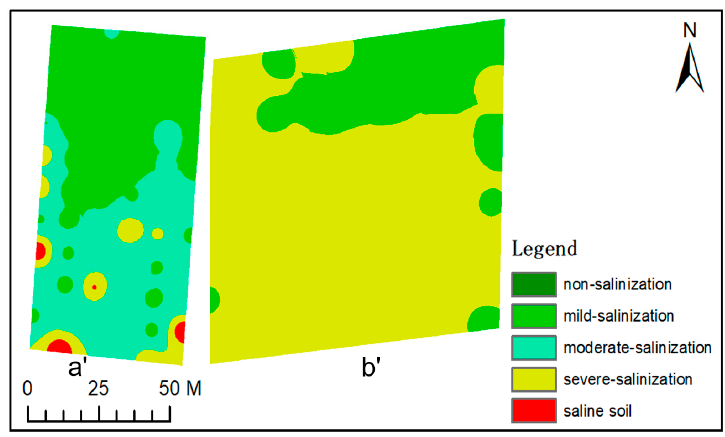
Figure 4. Salinity inversion map ( a , b ) and regional interpolation map ( a’ , b’ ) of sampling points in the test area.